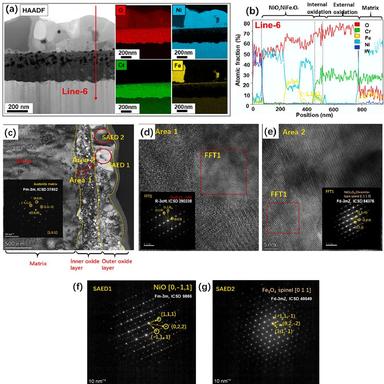
(a) the TEM HAADF and the O, Ni, Cr, Fe element EDS mapping results of the thicker oxide scale (Region C in formed in SCW at 600 ◦C for 1000 h, (b) EDS line scan (Line scan 6) across the thicker oxide scale, (c) cross-sectional TEM image of the thicker oxide scale, (d) high-resolution TEM imaging and FFT analysis of Area 1 in (c) external oxidation layer, (e) high-resolution TEM imaging and FFT analysis of Area 2 in (c)- internal oxidation layer, (f) SAED pattern obtained from area SAED1 area i